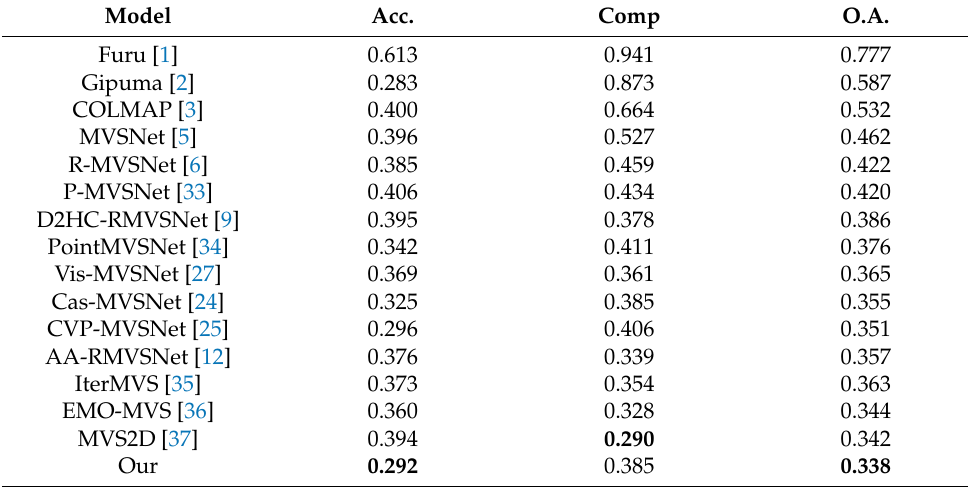
Table 2. Quantitative results on DTU evaluation dataset (lower is better).